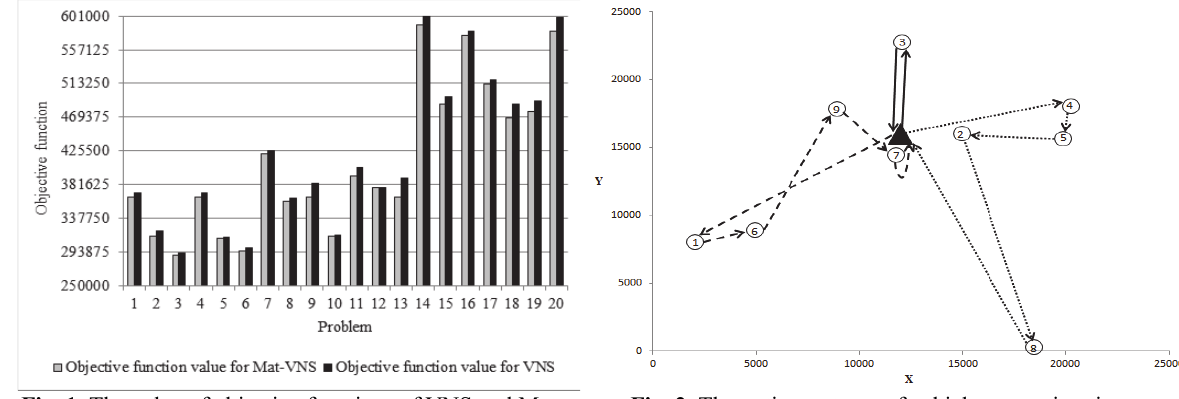
Fig. 1. The value of objective functions of VNS and Mat- VNS algorithms for problems with high dimensions